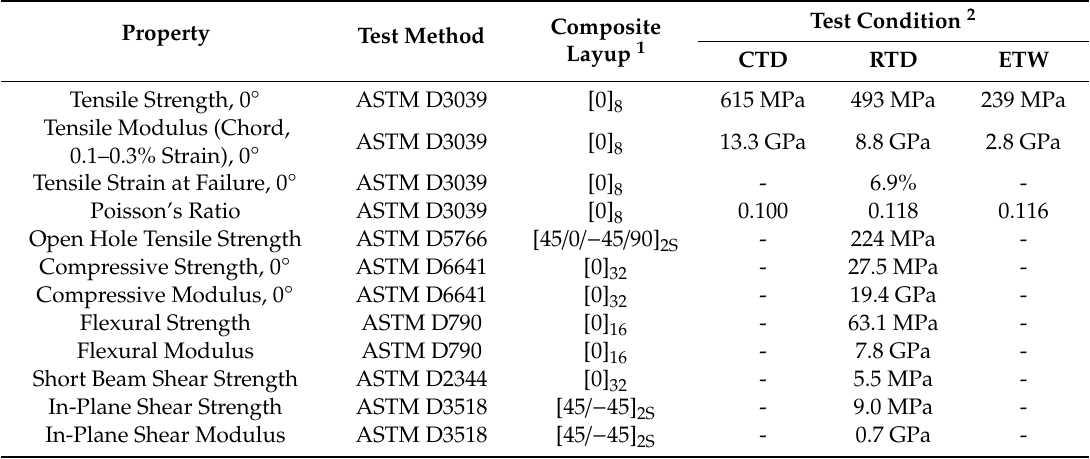
Table 3. Summary of ultra-high molecular weight polyethylene (UHMWPE) / poly(3BOP-daC12) composite mechanical